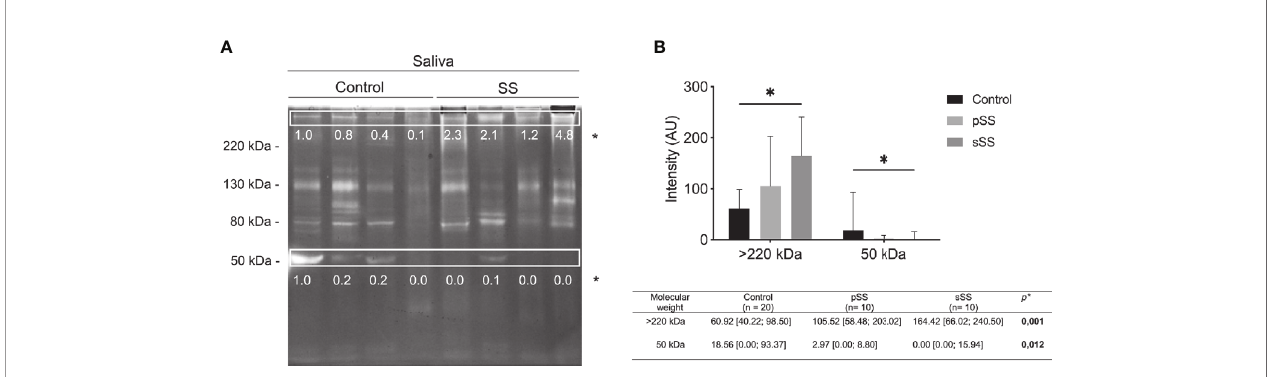
FIGURE 2 | Gelatinolytic activity pro fi le in saliva from healthy and Sjögren ’ s syndrome individuals. (A) Protease activity analysis of 10 m l SWS proteins (per lane) from healthy or SS individuals. Gels (8% polyacrylamide with 0.1% gelatin, w/v) were stained with Coomassie Brilliant Blue R250. Clear bands on dark background indicate sites of protein degradation. Spearman ’ s correlation test. Molecular weight markers (kDa). (B) The intensity of activity bands was assessed by densitometry using the software ImageJ. The most concentrated sample from a control individual was used as the standard to achieve the relative intensity to normalize the image. Mann – Whitney test. *p < 0.05.